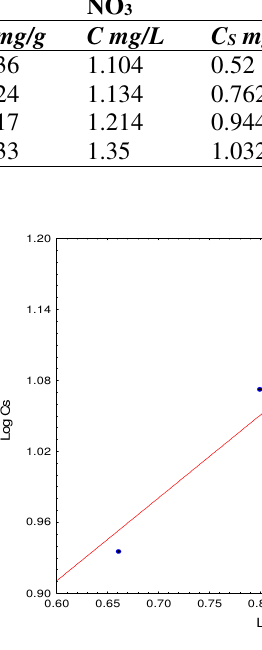
Fig. 23. Plot the concentrations according to Freundlich adsorption isotherm for TOC.